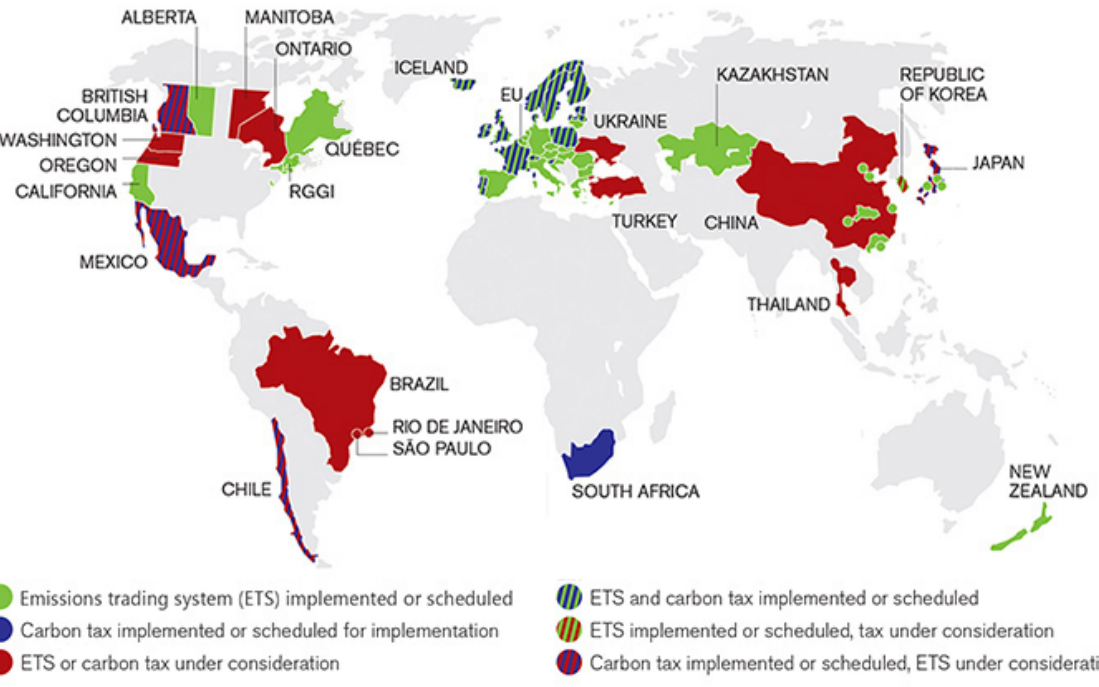
Figure 4: Who is playing the carbon